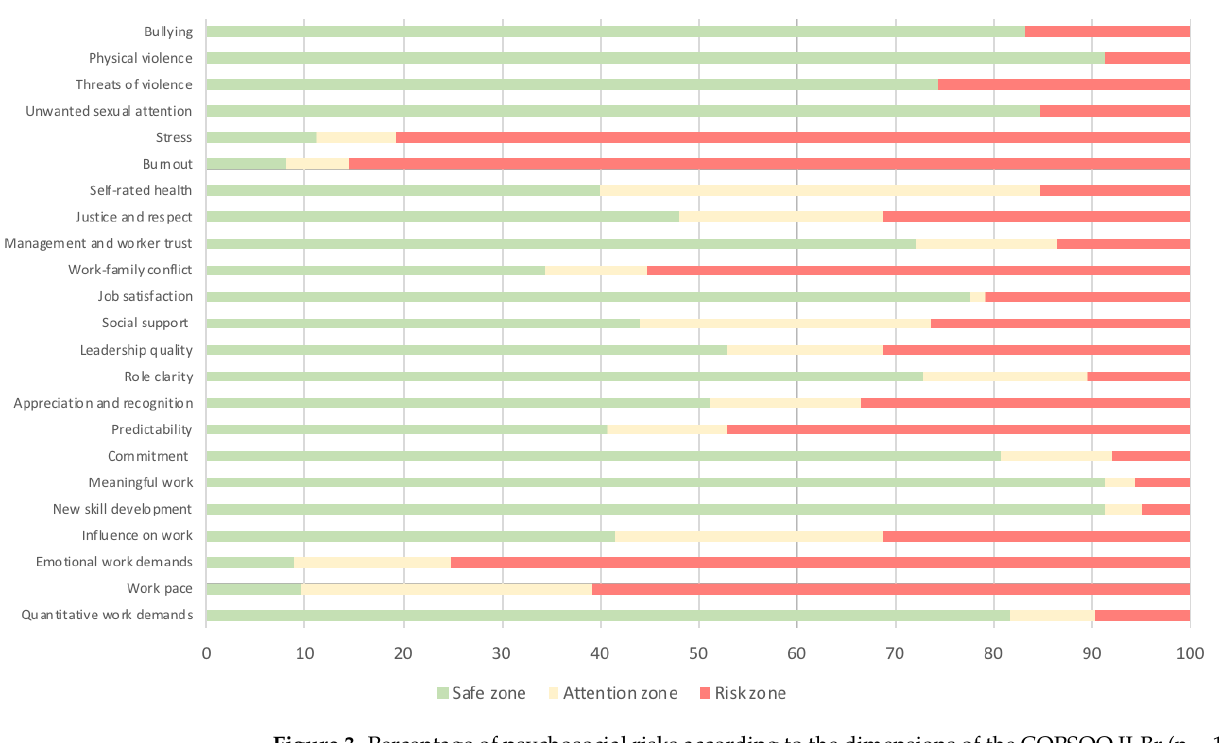
Figure 3. Percentage of psychosocial risks according to the dimensions of the COPSOQ II-Br (n = 125). Data are expressed as %.